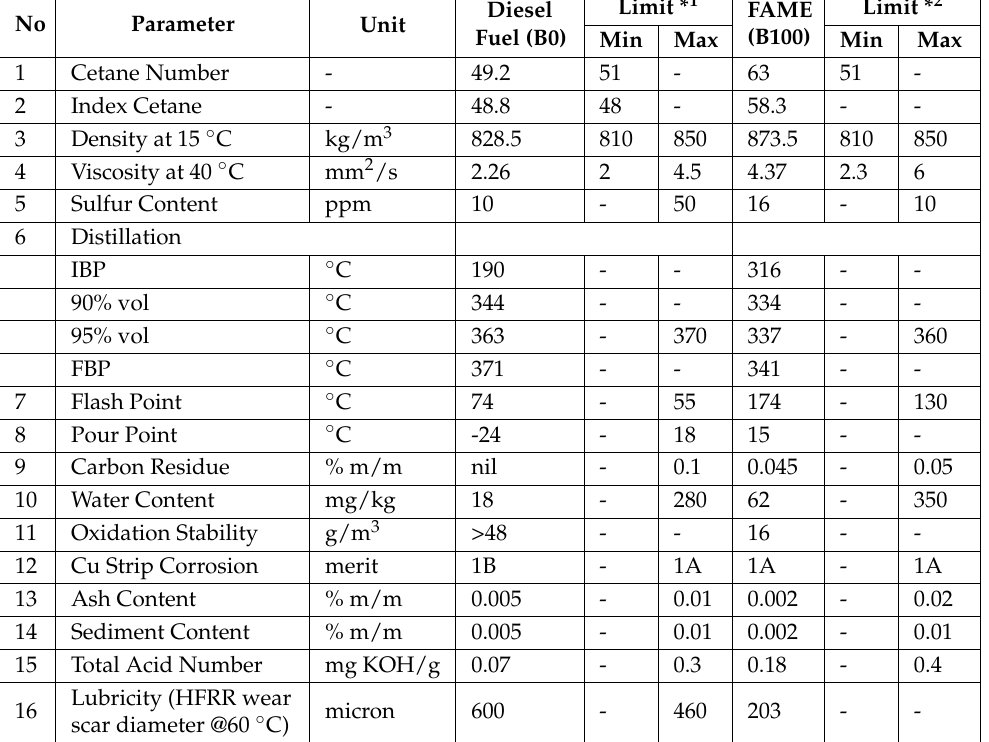
Table 1. Properties for diesel fuel and B100.